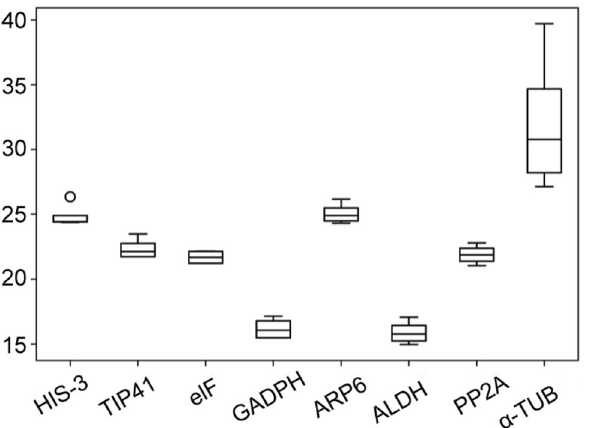
Figure 2. Distribution of RT-qPCR Ct values for the eight candidate reference genes across all S. pennata samples. The S. pennata materials of rhizosheaths of different development stages, roots, leaves, flowers, nodes, seeds, and PEG-treated roots were used for RNA extraction and cDNA synthesis that were then utilized for RT-qPCR reactions. Each RT-qPCR Ct value is the average of three independent experiments. The median (horizontal line), upper and lower quartiles (box), and maximum and minimum values (whisker) of each gene are displayed.